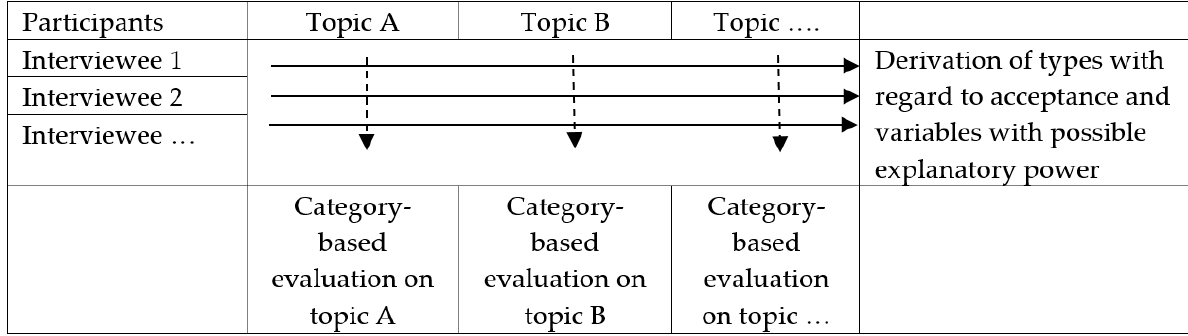
Figure 5. Schematic representation of the data analysis.